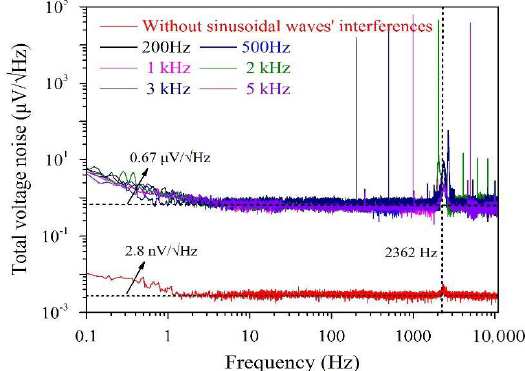
Figure 4. The spectra of the LC resonance magnetic sensor with and without manual sinusoidal waves’ interference in a magnetically shielded room.